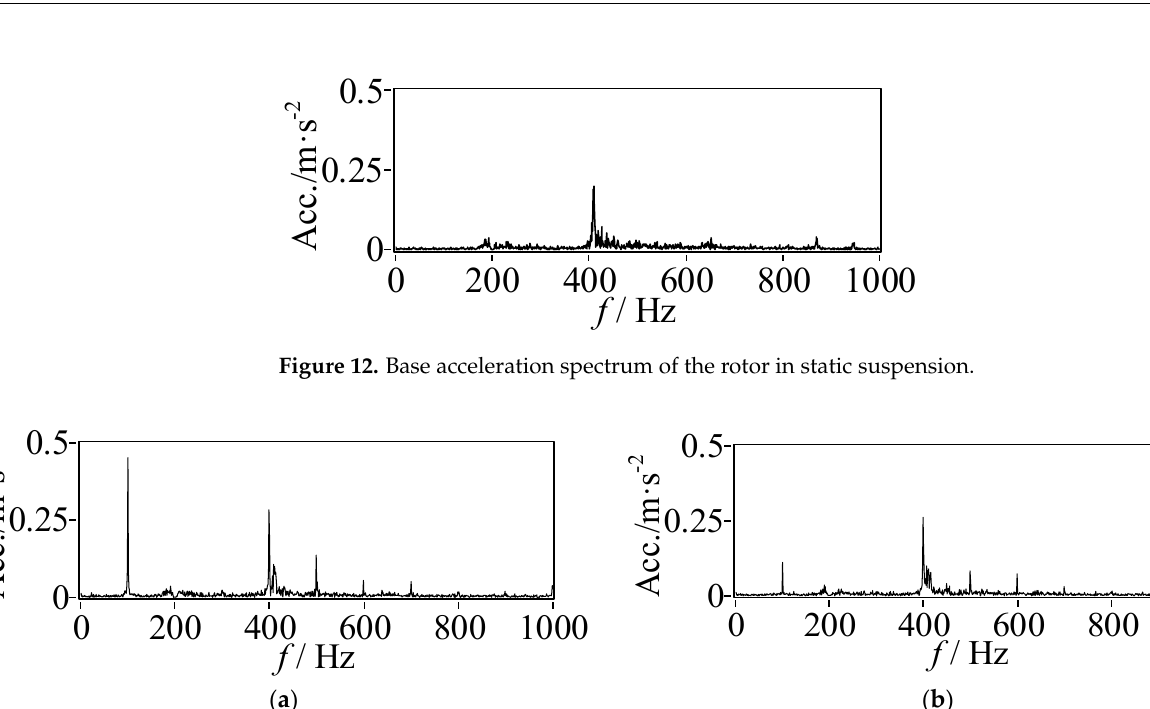
( d ) Figure 11. The amplitude-frequency diagram of displacement and current after rotor LMS harmonic compensation. ( a ) Time domain spectrum of displacement; ( b ) Time domain spectrum of current; ( c ) Frequency spectrum of displacement; ( d ) Frequency spectrum of current. The data with a time of 1 s were randomly taken, and the peak-to-peak mean was obtained. The results are shown in Table 1. Compared with the uncompensated, the peak- to-peak average value of the rotor displacement vibration is reduced by 67.4% and the peak-to-peak average value of the control current is reduced by 31% after using the fun- damental frequency and harmonic vibration control algorithm based on LMS in this pa- per. Compared with the displacement and control current in static suspension, they only increased by 32.6% and 6.5%, respectively. Table 1. Rotor Displacement and Current Peak-Peak Mean Value. Peak-Peak Mean Value Displacement ( μ m)